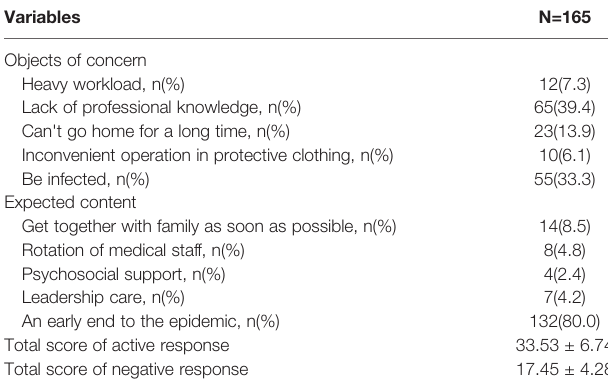
TABLE 2 | The medical staff's most troublesome concerns and prevalent expectations.